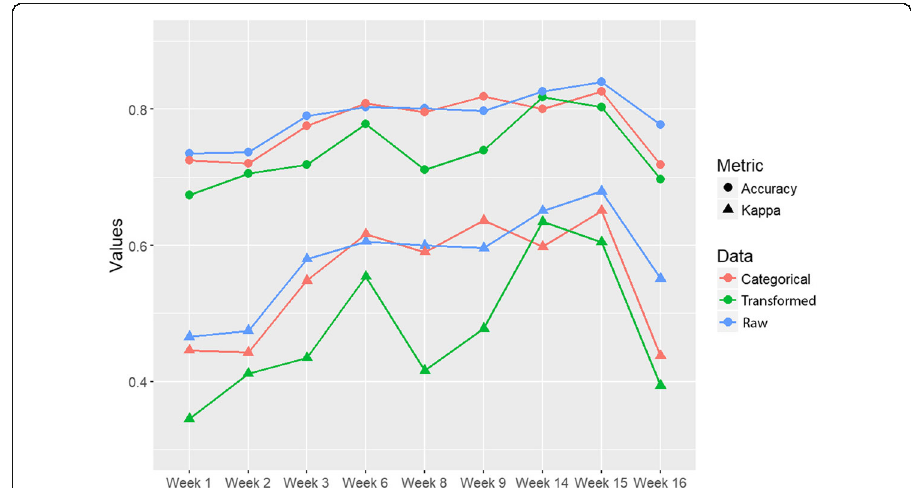
Fig. 5 Visualization of Accuracy and Kappa values